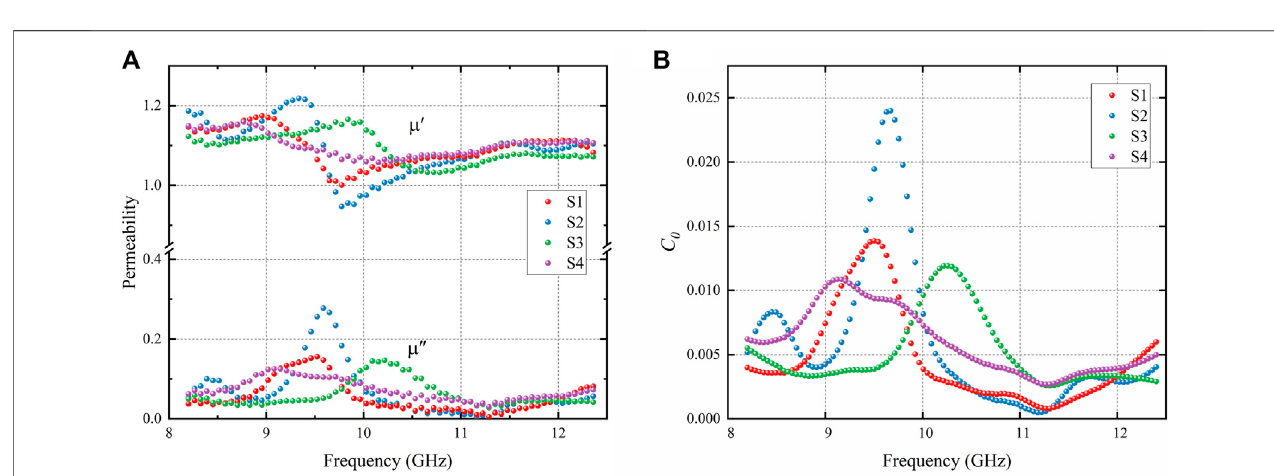
FIGURE 8 | (A) complex permeability (B) eddy current coef fi cients of four samples.